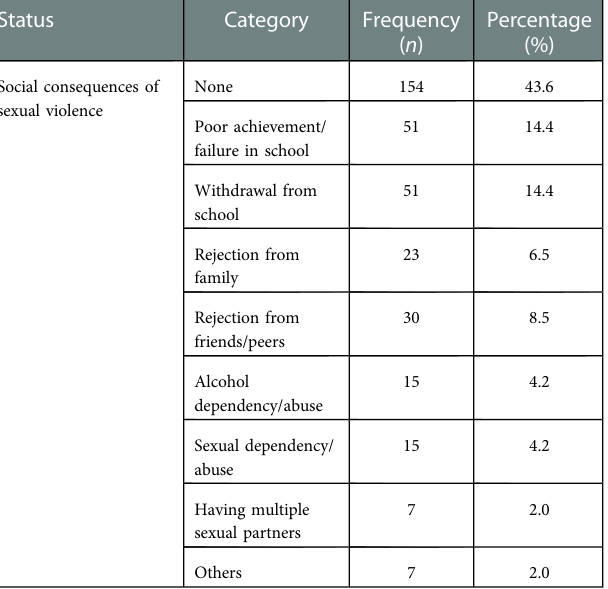
TABLE 6 Prevalence of physical and sexual violence before joining the university, since joining the university, and in the year the study was conducted; among female Wolkite University students, 2021. Variables